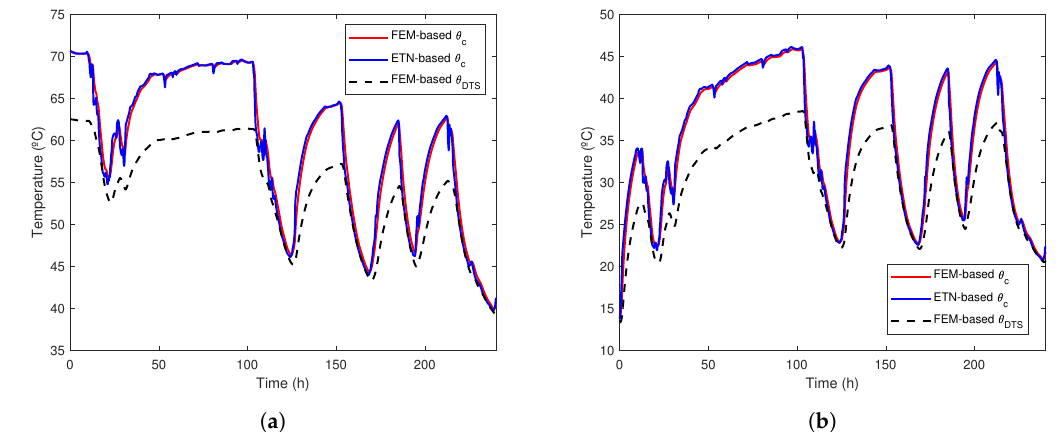
Figure 22. Estimation results for θ c in Cable 1E: ( a ) Case 1; ( b ) Case 2.